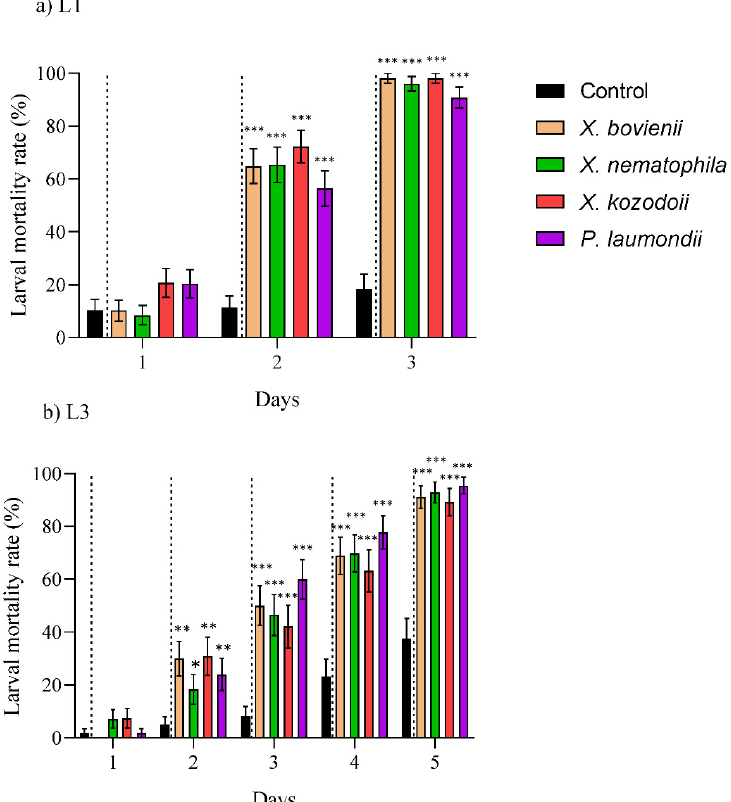
Figure 2. Toxic effect of the natural products produced by the symbiotic bacteria Xenorhabdus bovienii , X. nematophila , X. kozodoii , and Photorhabdus laumondii included in the cell-free supernatants tested against various larval instars of the European grapevine moth, Lobesia botrana. ( a ) First instar (L1) and ( b ) third instar (L3). Data are presented in days (from 1 up to 3 or 5 days, x-axis) and measured as larval mortality rate (%) (y-axis). Asterisks indicate significant differences at *** p < 0.001, ** p <0.01, * p < 0.05. Values are least-square means ±